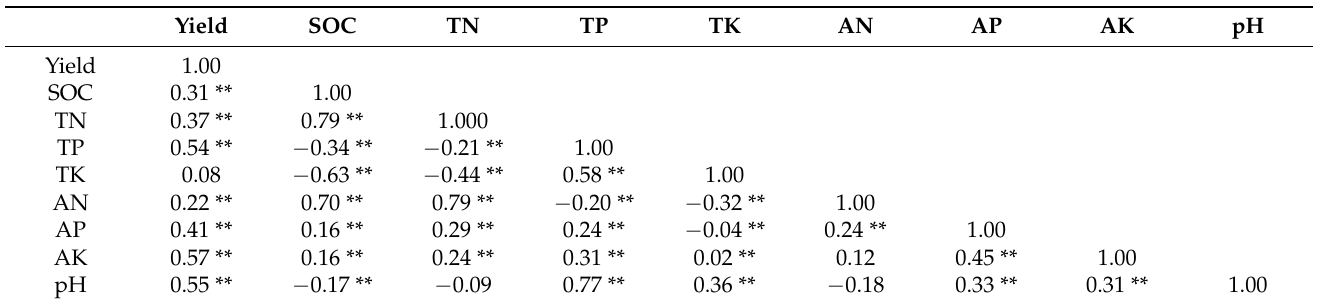
Table 4. Correlation between rice yield and influencing factors ( N = 236).